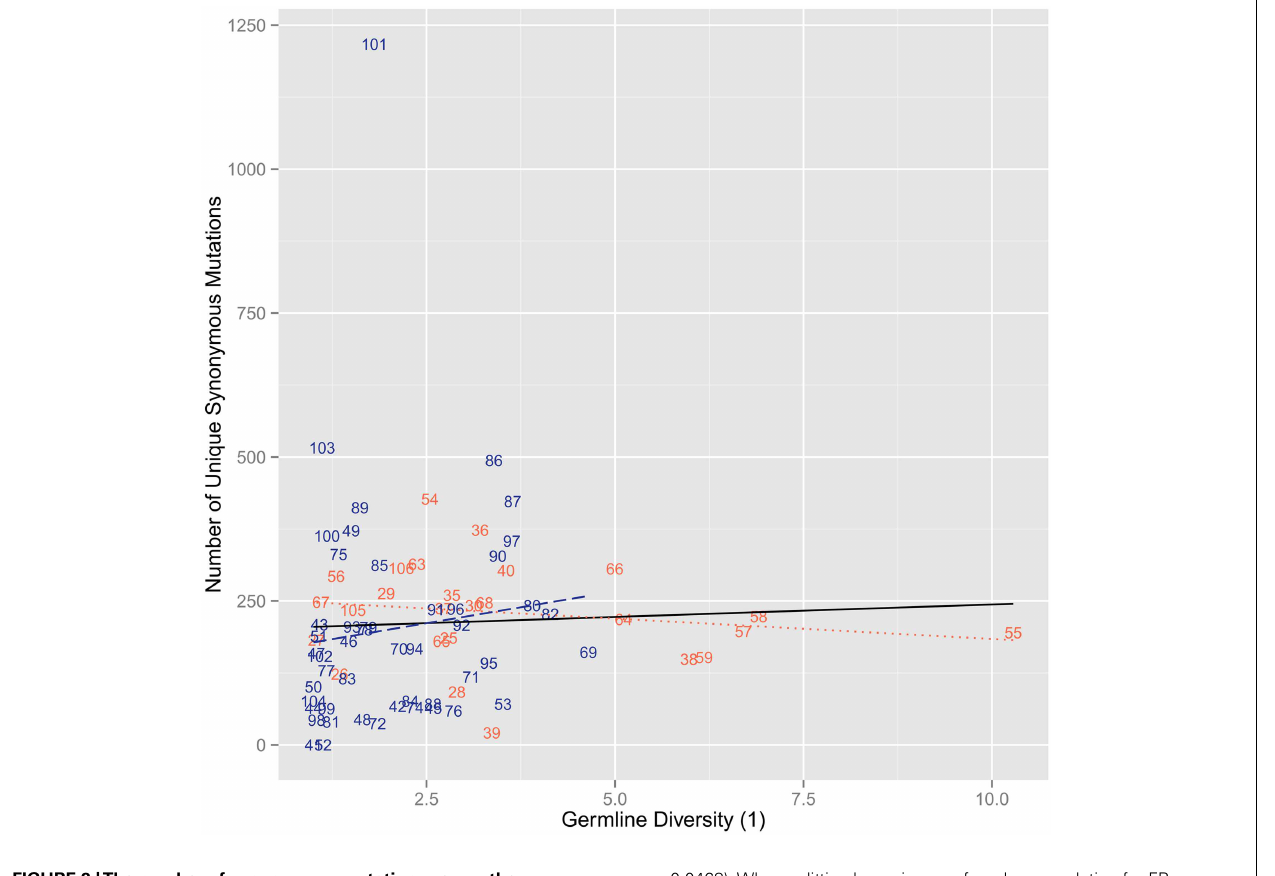
FIGURE 2 |The number of synonymous mutations versus the diversity of order 1 of the germline sequences per position .We found no positive correlation with a flat trend ( r 2 = 1.87 × 10 − 3 , ρ = 0.232,